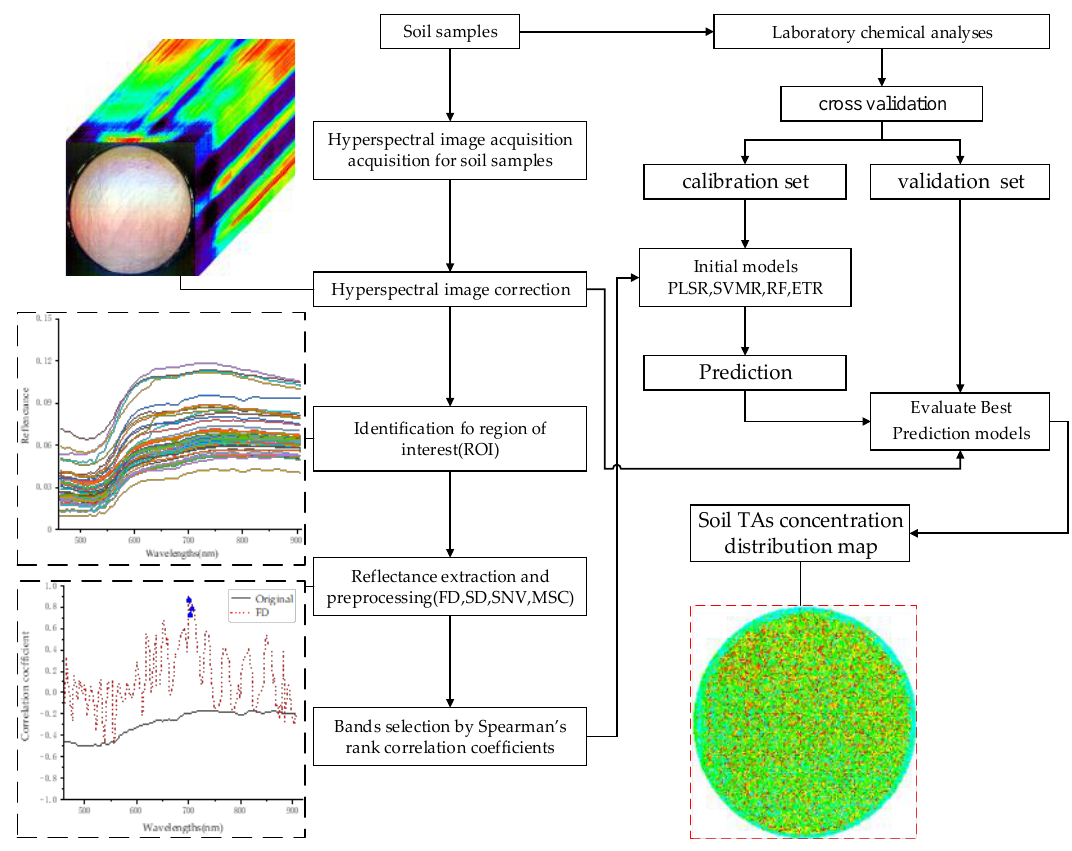
Figure 3. Main steps of this work.